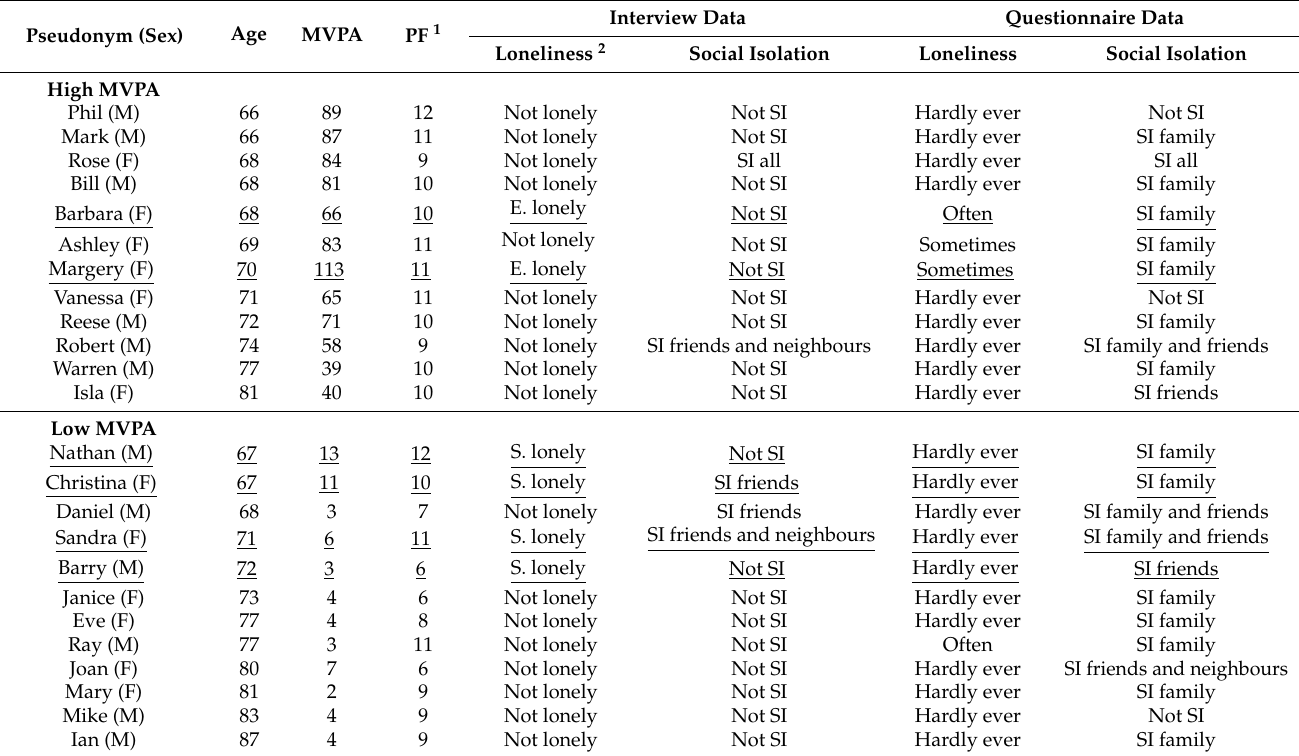
Table 2. Participant characteristics in the low- and high-moderate-to-vigorous physical activity (MVPA)